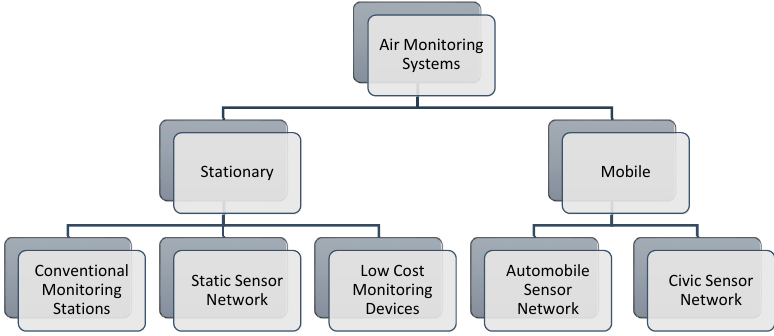
Figure 2. Air monitoring system’s categories presented in the recent literature.